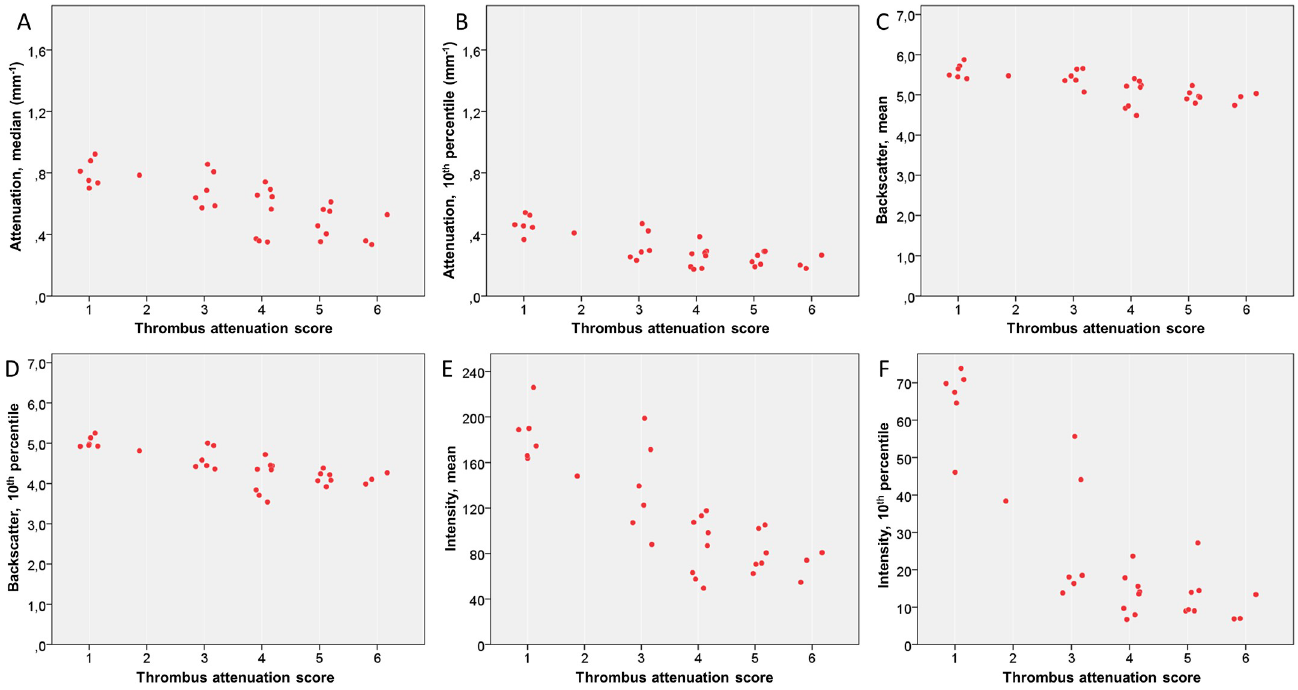
Fig 3. Relationship of thrombus attenuation score and parameters measured by image analysis software in thrombus areas in OCT images. Scatterplots for median attenuation (A), 10 th percentile of attenuation (B), mean backscatter (C), 10 th percentile of backscatter (D), mean grayscale intensity (E) and 10 th percentile of grayscale intensity (F). OCT, optical coherence